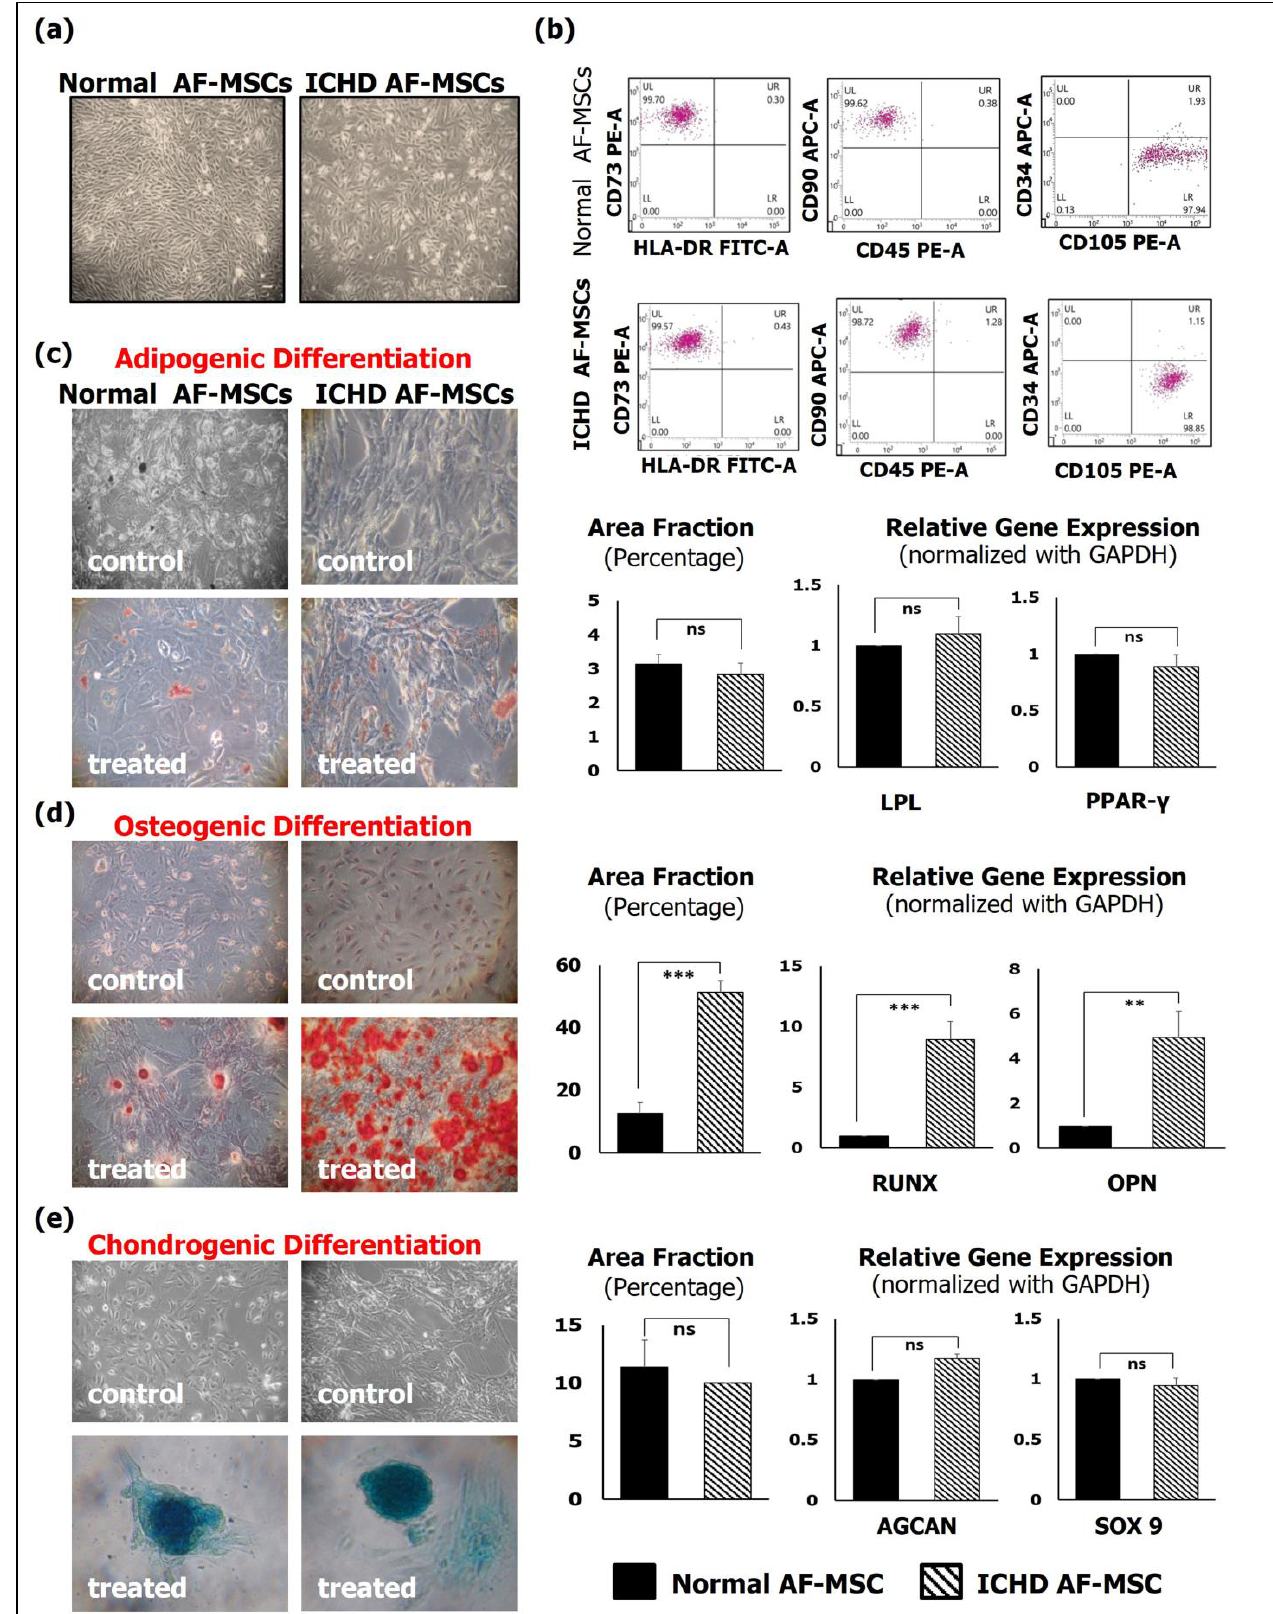
Figure 1. Morphology and characterization of normal and ICHD AF-MSCs. ( a ) Representative microphotographs of both types of AF-MSCs, showing uniform spindle-shaped morphology at